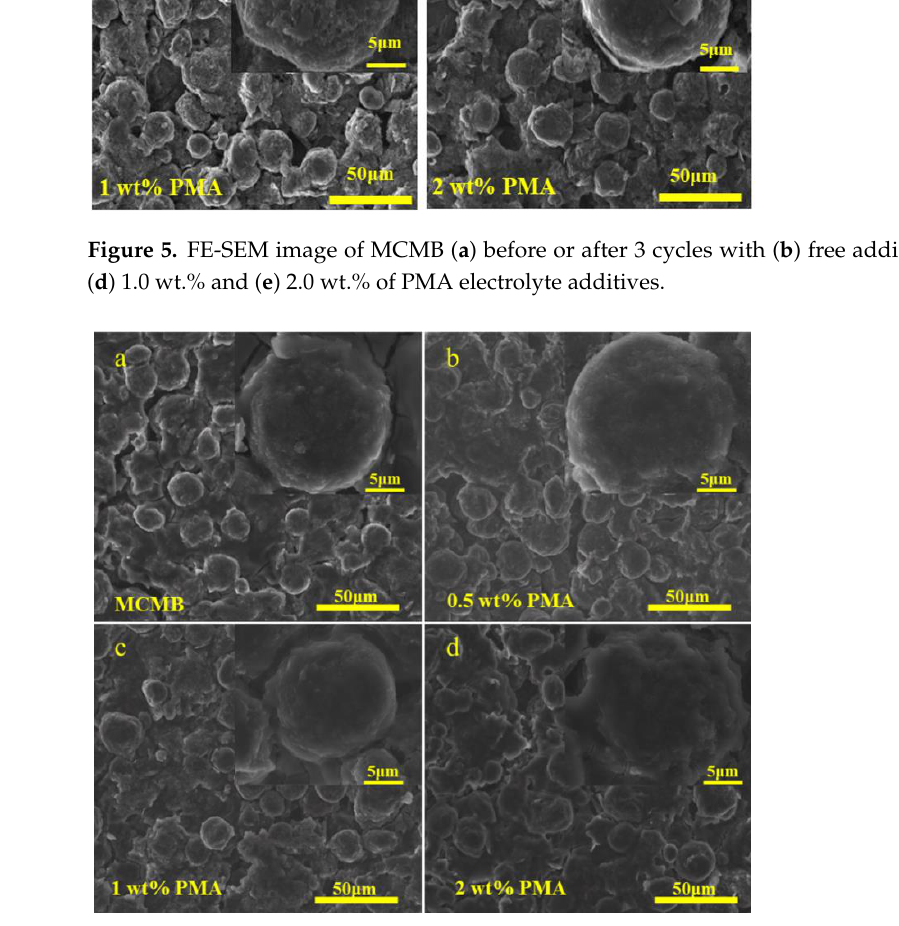
Figure 6. FE-SEM images of MCMB electrodes tested in the base electrolyte containing ( a ) 0.0 wt%, ( b ) 0.5 wt% ( c ), 1.0 wt% and ( d ) 2.0 wt% PMA at elevated temperature.